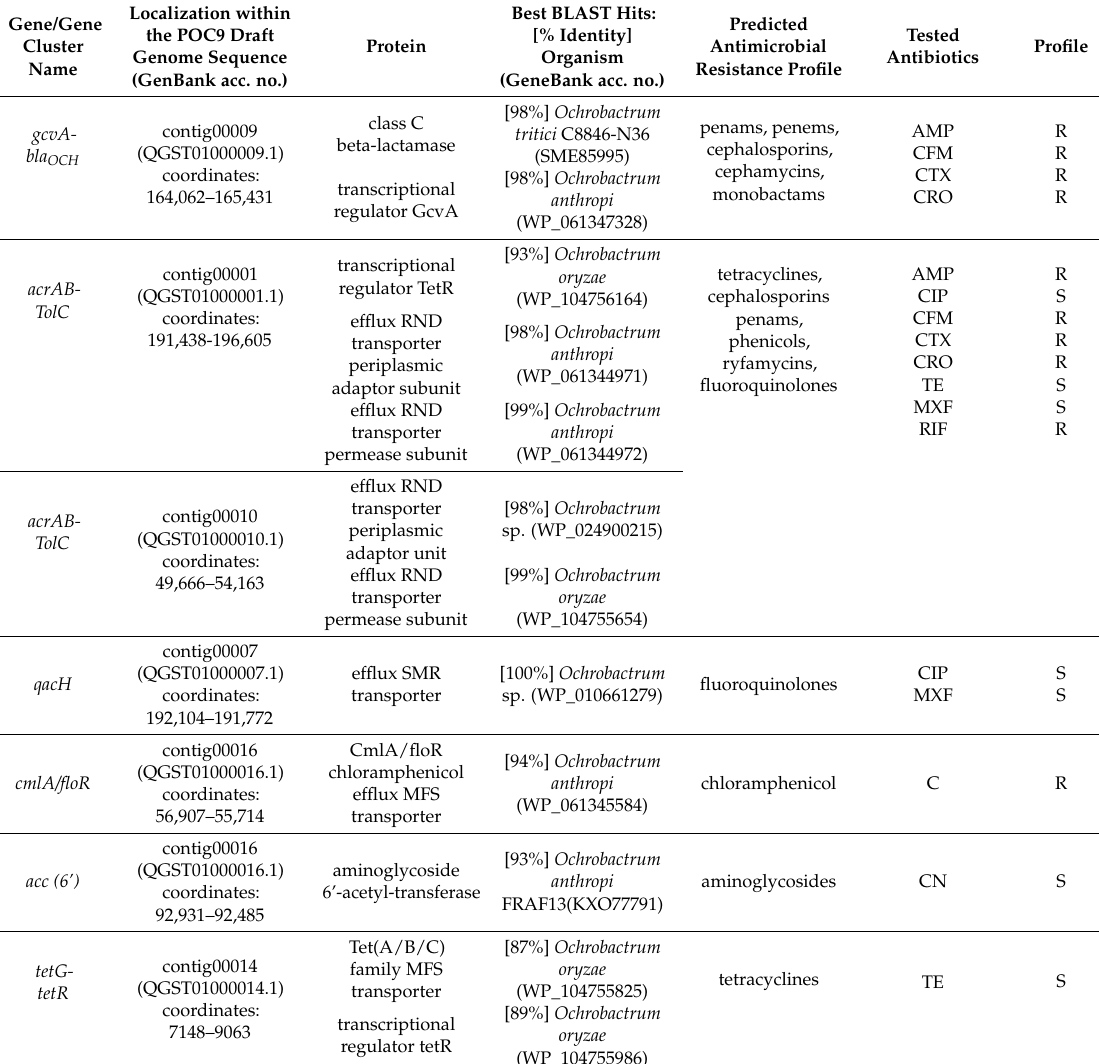
Table 5. Antibiotic resistance genes identified within the Ochrobactrum sp. POC9 draft genome and the resistance profile of the